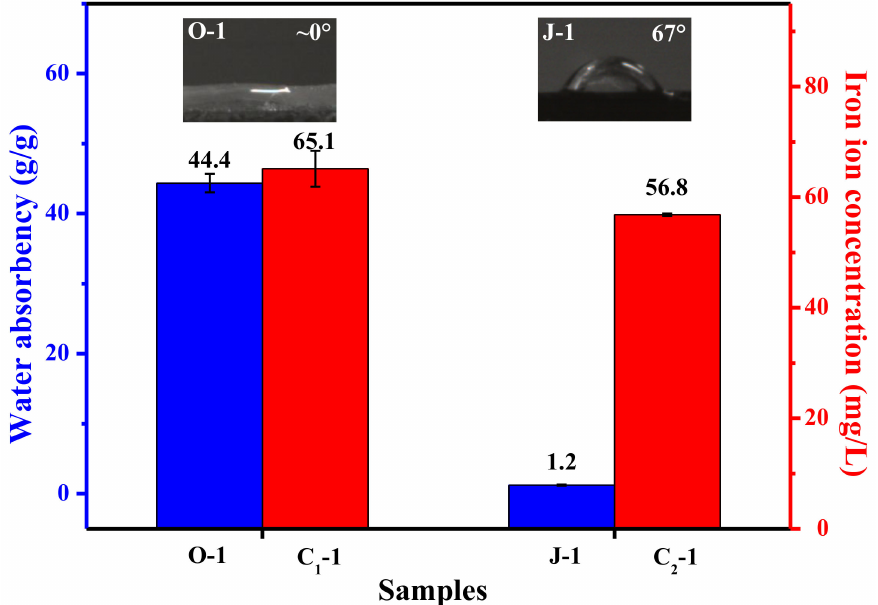
Figure 4. Water absorbency of the fiber sample and the concentration of iron ions leached into the treated MB aqueous solution; fiber O-1 is defined in Section 2.3, and the fibers J-1, C 1 -1, and C 2 -1 are described in Section 2.4; iron ion concentration here refers to the average concentration of iron ions eluted into the MB aqueous solutions obtained during the first three cycles; the inset pictures show the water contact angle of the fiber